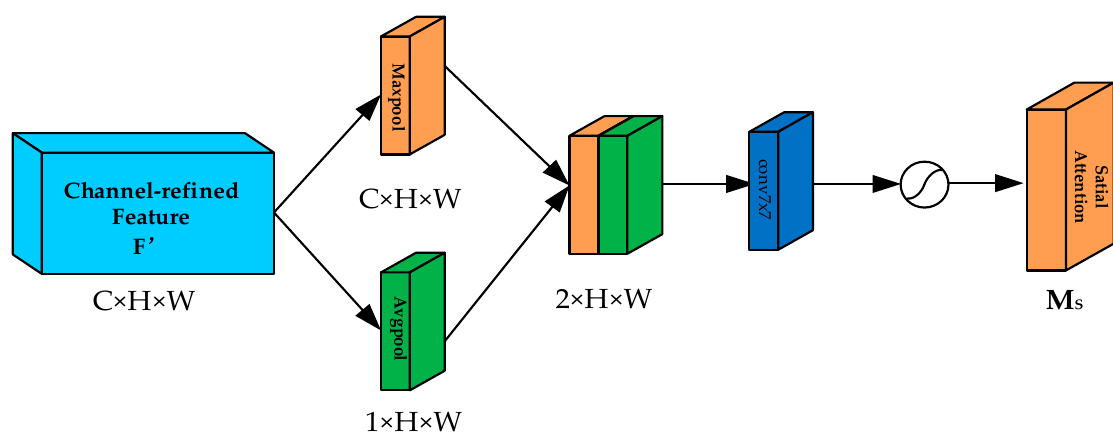
Figure 4. The spatial attention mechanism.